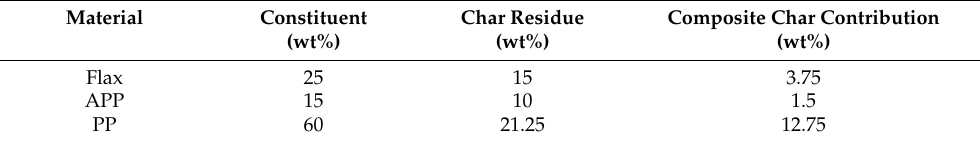
Table 5. Formulation of char residue for FDS based on thermogravimetric